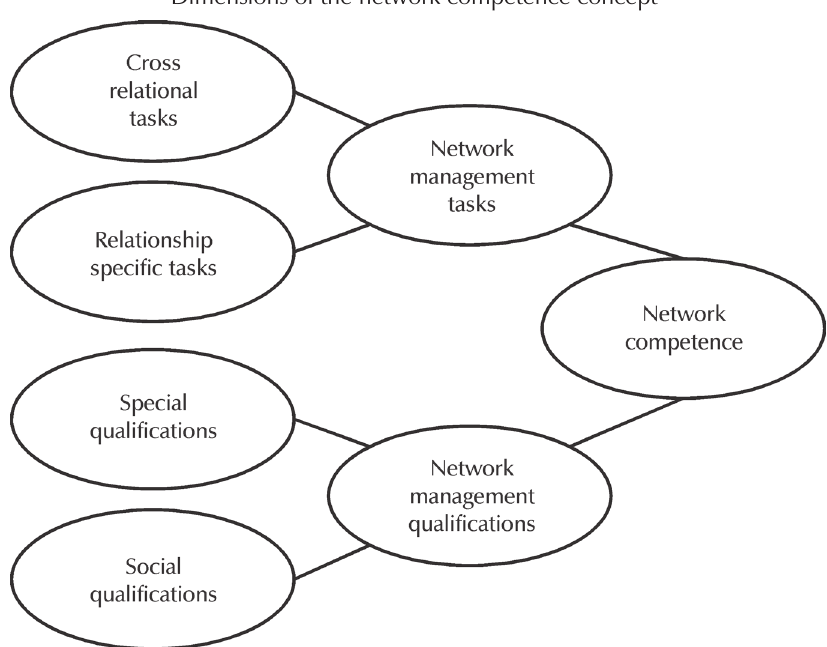
Dimensions of the network competence